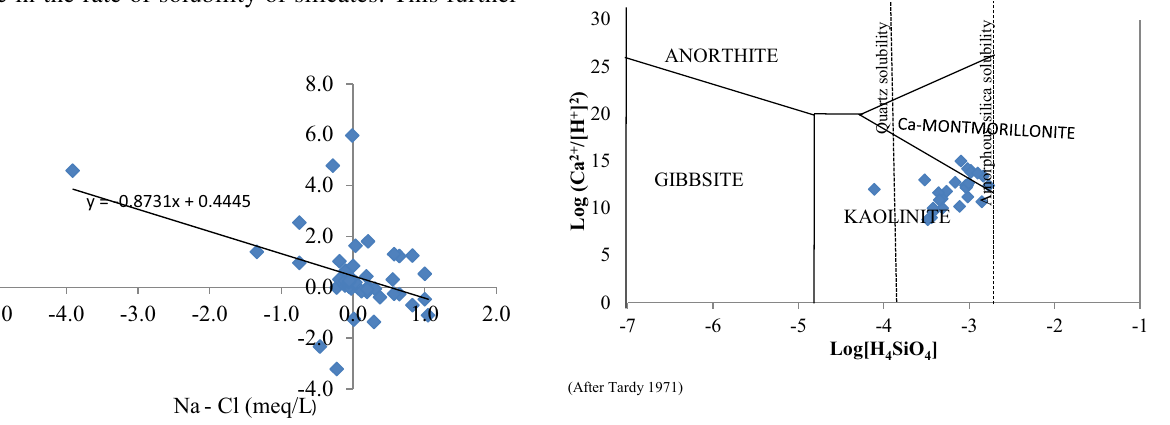
Fig. 10 Plot of Na–Cl (meq L −I ) vs. Ca + Mg − HCO L −I ) for groundwater within the Asutifi-North District